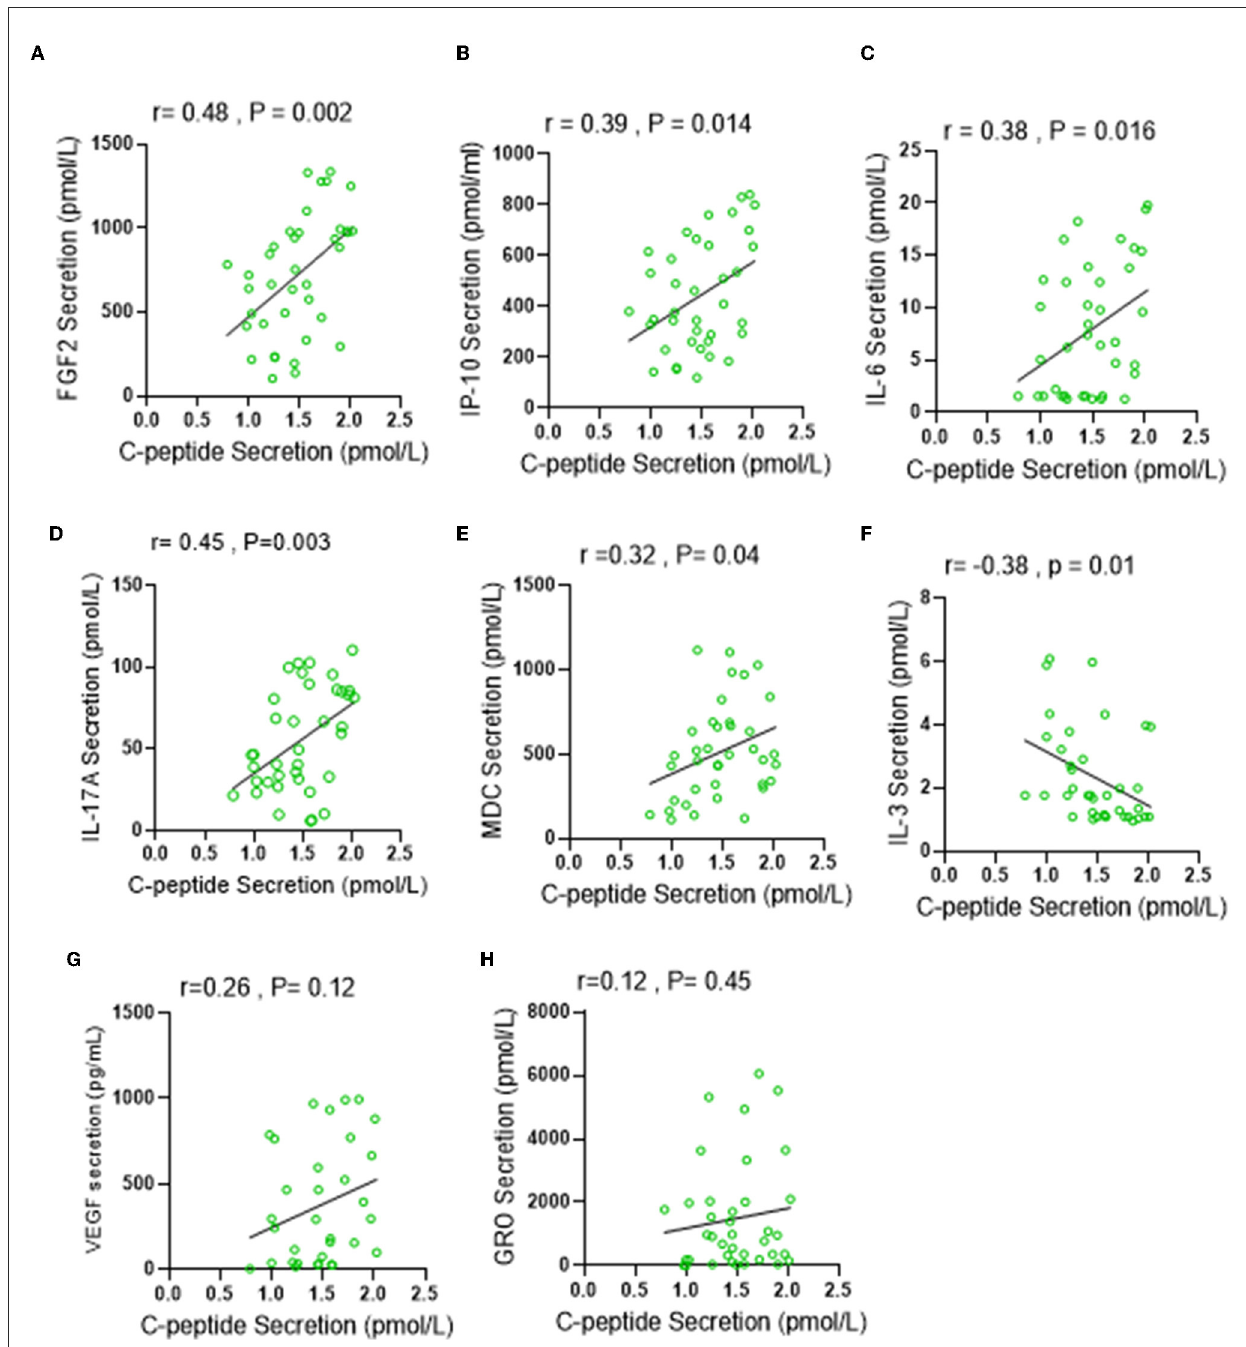
FIGURE4 Low carbohydrate (LC) intake is associated with IRS-related inflammatory markers under low carbohydrate intake. Plasma levels of IRS related secretion of 41 cytokine and chemokine were determined by multiplex Assay. (A–H) Spearman correlation analysis was conducted to investigate the relationship between significantly elevated cytokines in LC group and C-peptide secretion levels. All data are expressed as mean ± SD. P ≤ 0.05 was considered statistically